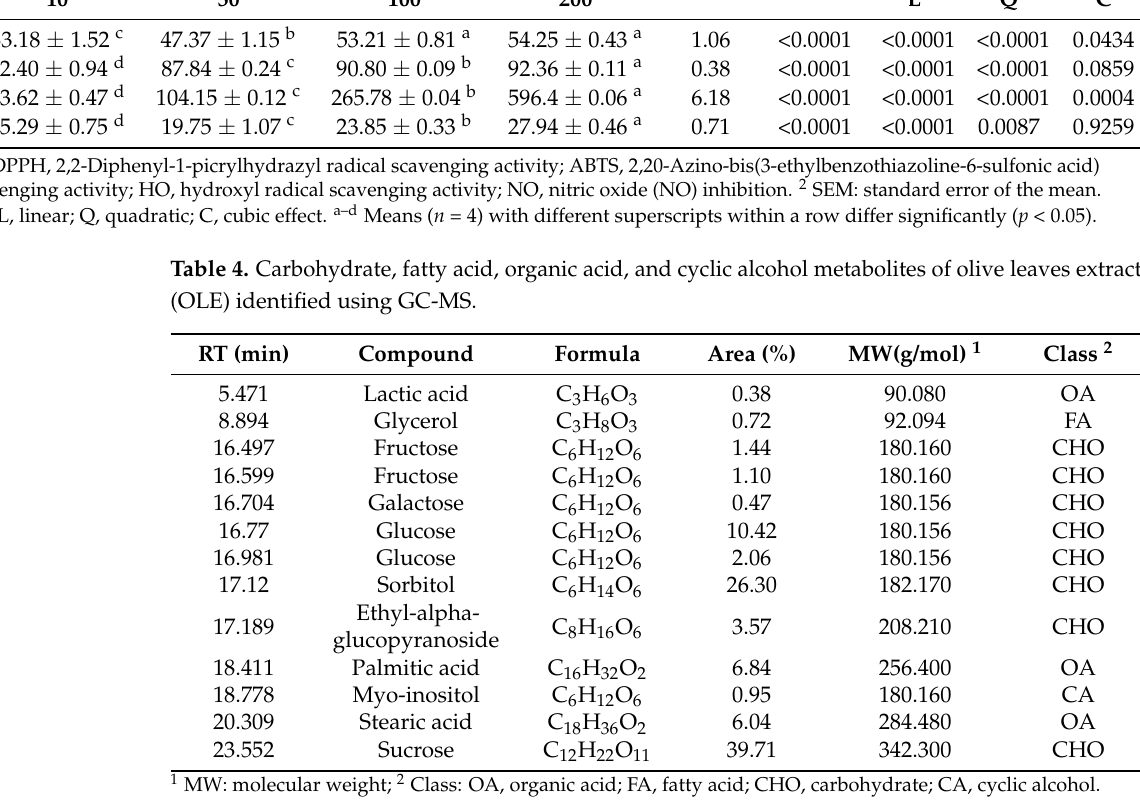
Table 3. Antioxidant capacities (DPPH, ABTS, HO) and nitric oxide (NO) inhibition of olive leaves (OLs) (DM basis, %). Content 1